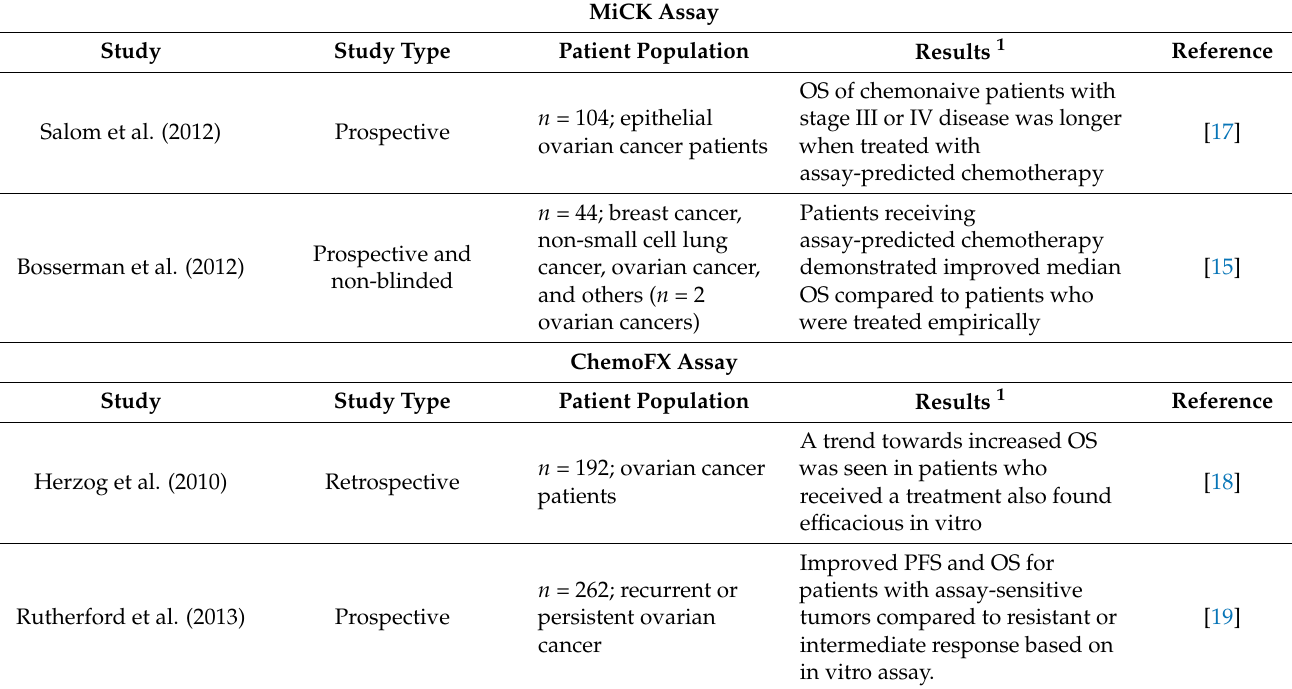
Table 1. Clinical trials with commercially available kits in ovarian